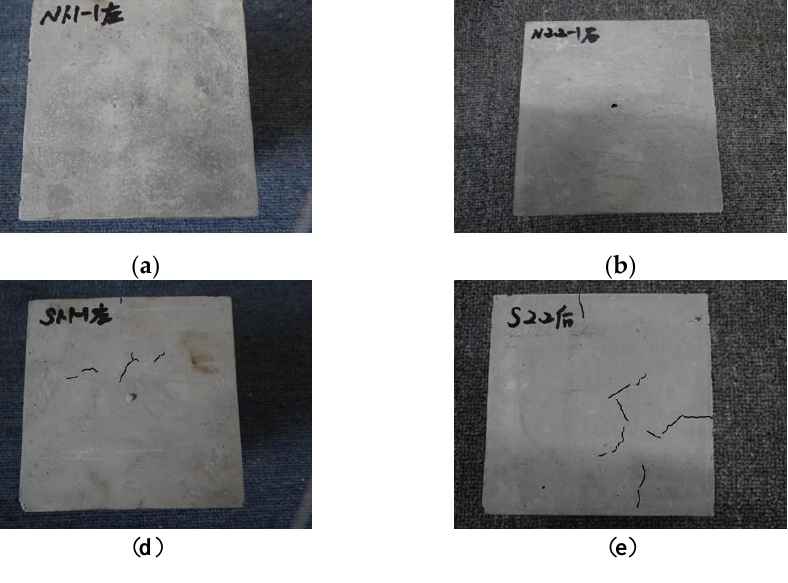
Figure 1. Appearances of specimens submerged in ( a ) 0.5 g/L ( b ) 4.5 g/L, ( c ) 15 g/L chloride solution, ( d ) 0.5 g/L, ( e ) 4.5 g/L, and ( f ) 15 g/L sulfate solution for 28 days (the size of the test piece face facing the photo is 100 mm*100 mm).